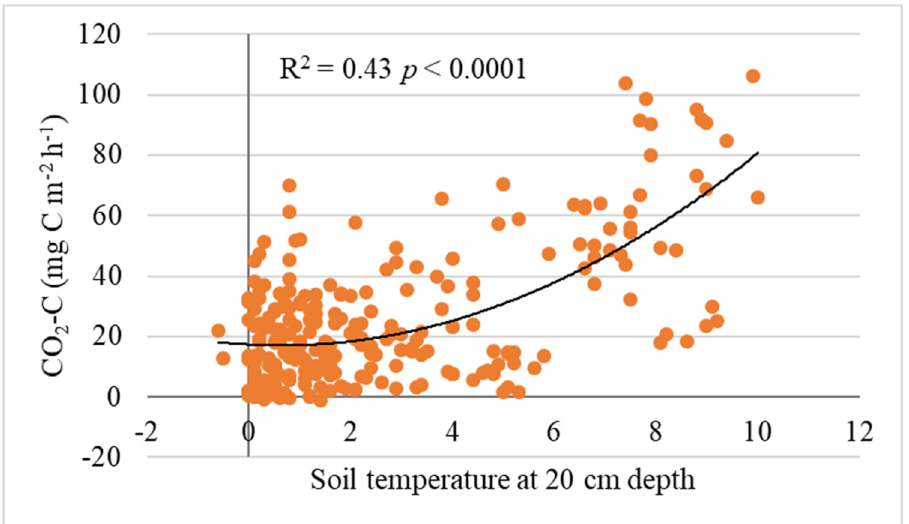
Figure 4. Cumulative annual CO 2 -C emissions at Norway spruce ( a ) and Downy birch ( b ) drained peatland forests and Ess-soo ( c ) and Laiuse ( d ) abandoned peat extraction areas.